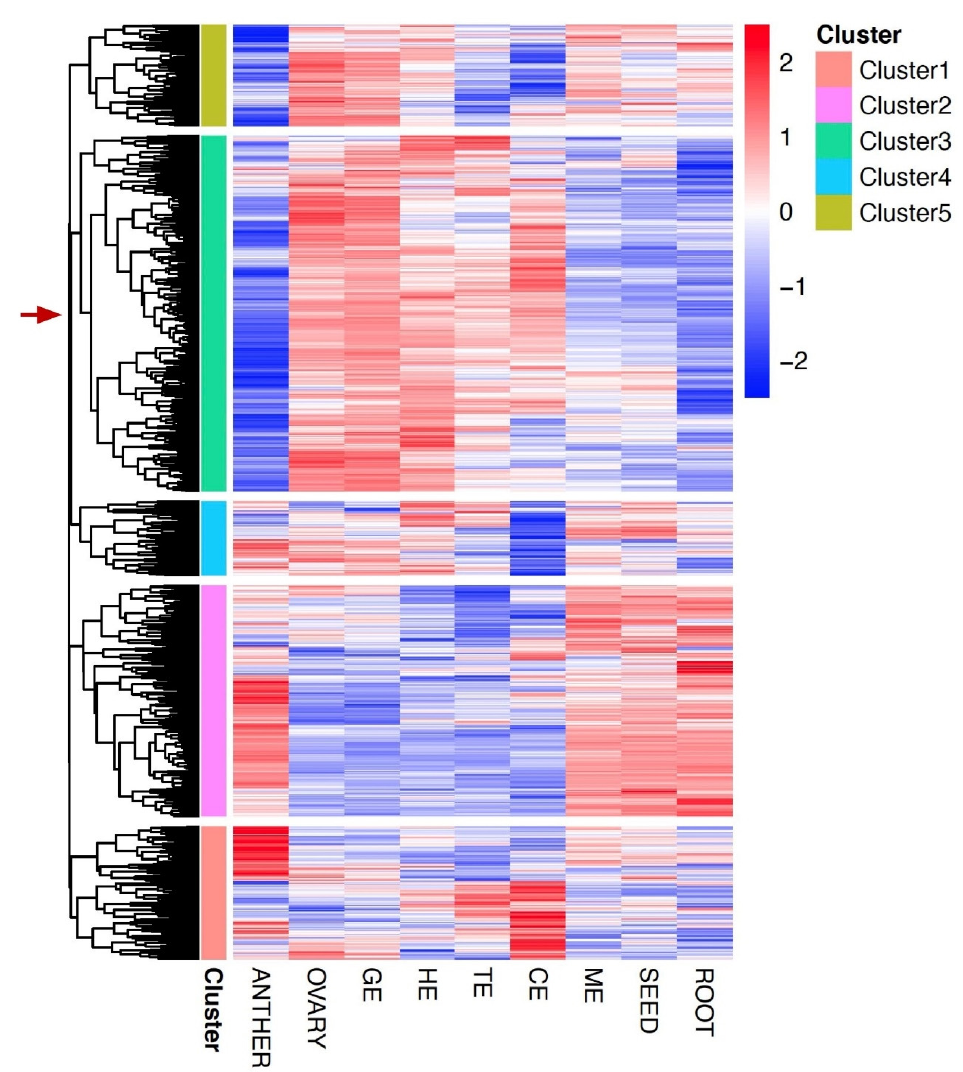
Figure 4. Cluster analysis of embryo-development-essential genes in flax. Heatmaps of clustered embryo-development-essential genes with similar expression patterns were generated. Five clusters were identified, shown with different colors as defined in the right inset. Z-score transformations of expression were performed for each gene across all tissues and stages of embryonic development. Expression levels were indicated by color scheme, from red (high) to blue (low) in corresponding tissues/stages, as defined in the inset. Genes in each cluster are associated with a color on the left of each heatmap3.6. Transcriptomic Regulation of Storage Reserve Genes in Flax.